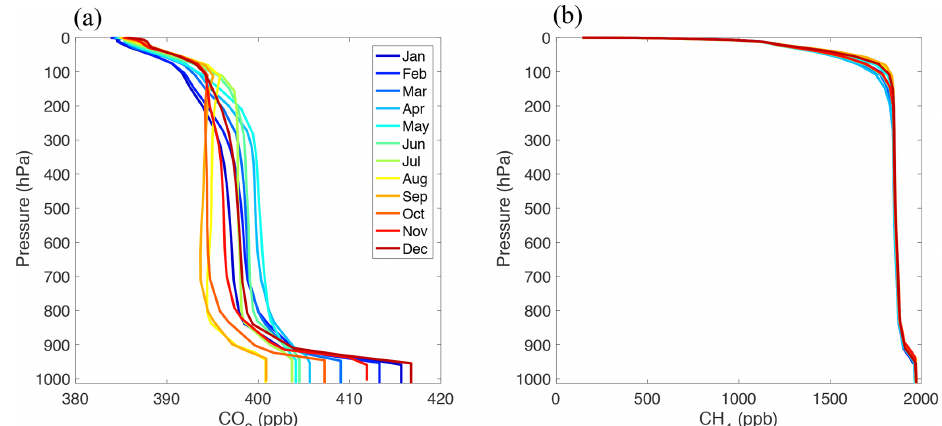
Figure 5. (a) CO 2 vertical profiles are extracted from the CarbonTracker model over Los Angeles with 3-hourly temporal resolution. Monthly averaged profiles are used as a priori profiles in GFIT3. (b) Monthly averaged CH 4 vertical profiles are adopted from CLARS-GFIT. A constant PBL enhancement of 91ppb, as estimated by Verhulst et al. (2017; Table 5) using the NASA Megacity network, is added. The hourly variability in CH 4 in the PBL is assumed to be the same as that of CO 2 since they are co-emitted and follow a similar atmospheric mixing process.